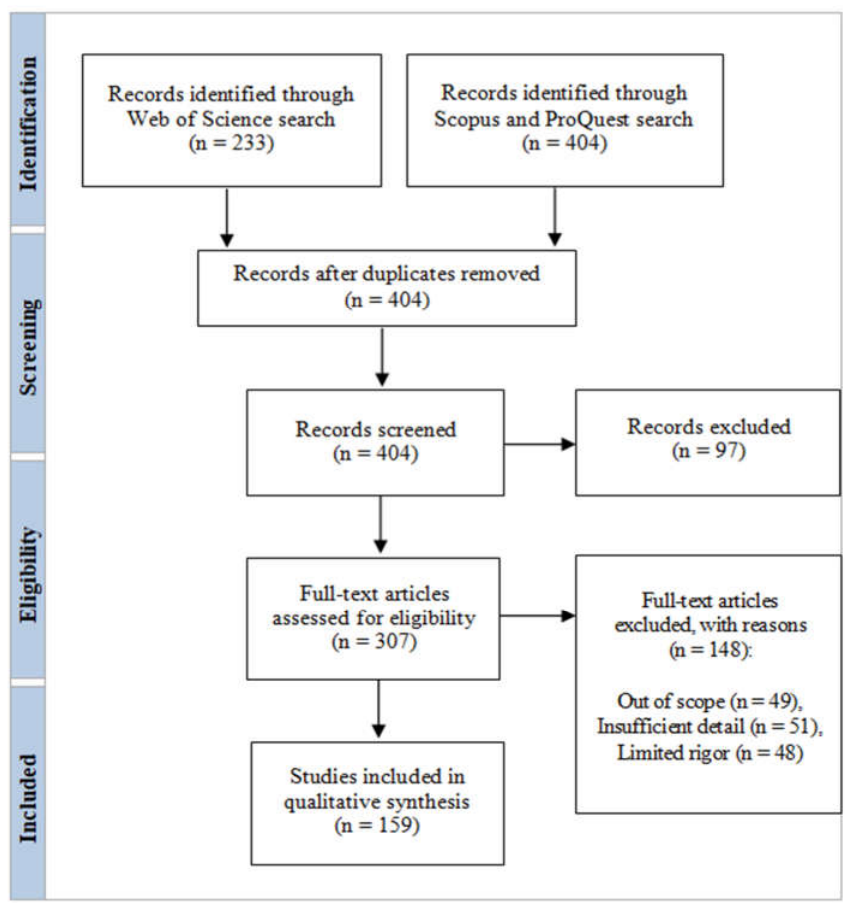
Figure 5. PRISMA flow diagram describing the search results and screening.